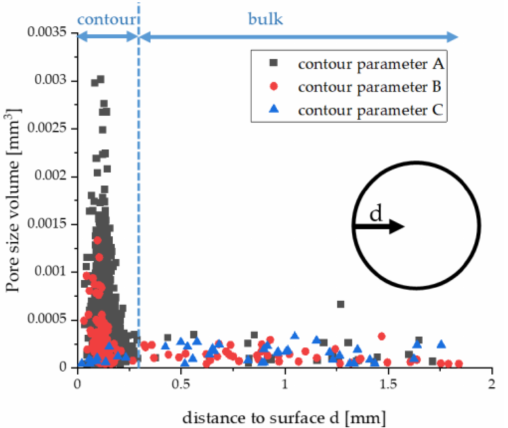
Figure 6. Pore size distribution of the manufactured specimens with differing contour parameters dependent of the distance to the surface.